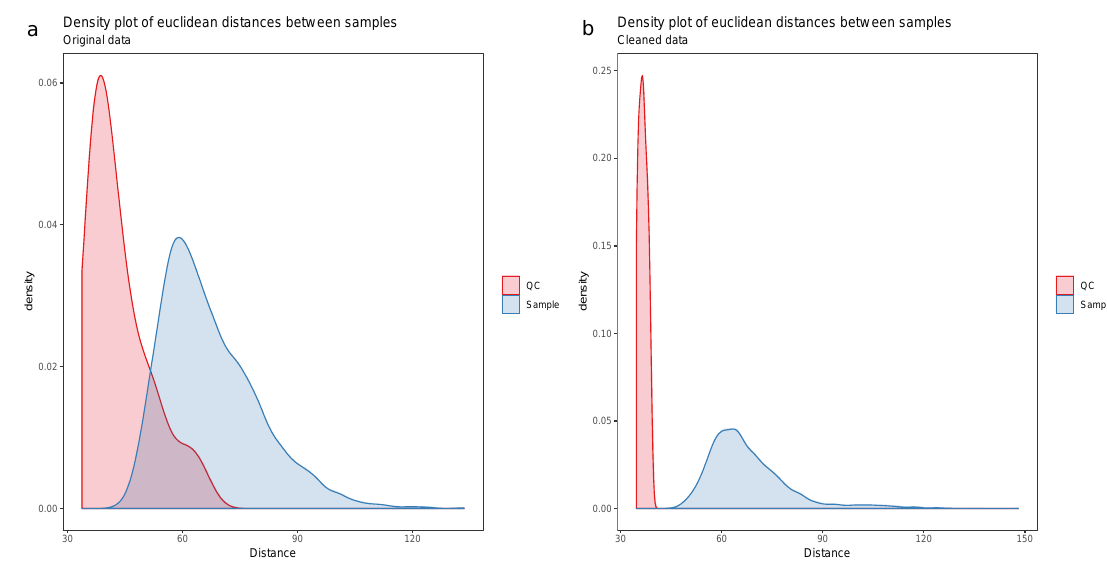
Figure 7. The density plot ( a ) shows a clear overlap between the distribution of quality control (QC) samples and the biological samples, which indicates poor data quality. After drift correction and quality control ( b ), the distributions are no longer overlapping.